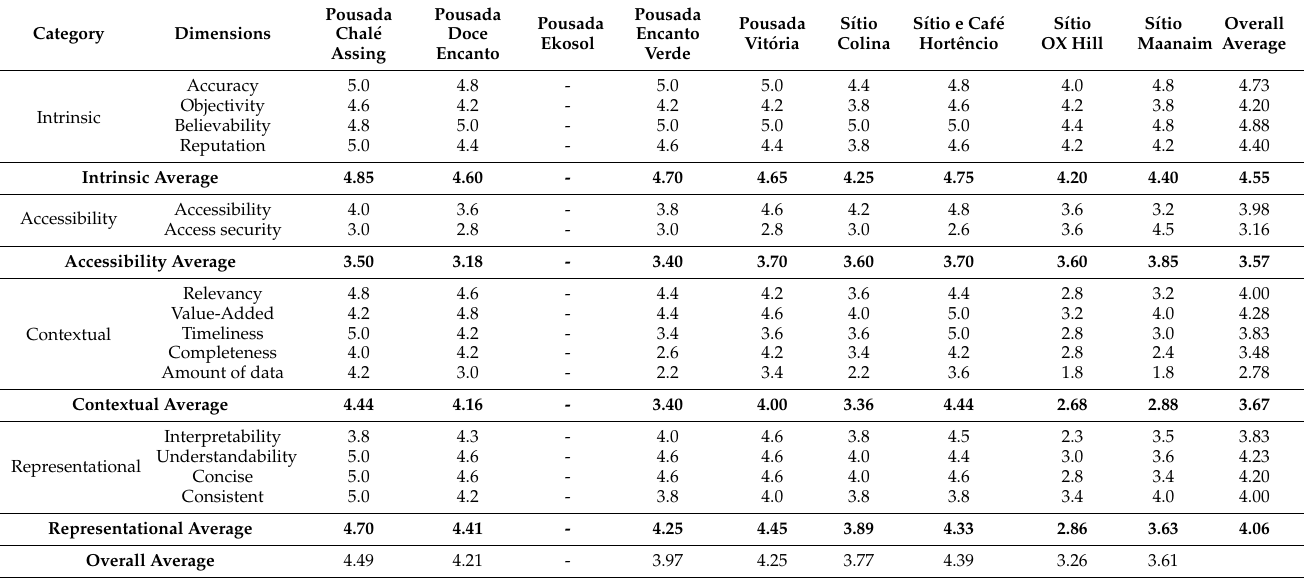
Table 2. Averages by categories and dimensions.